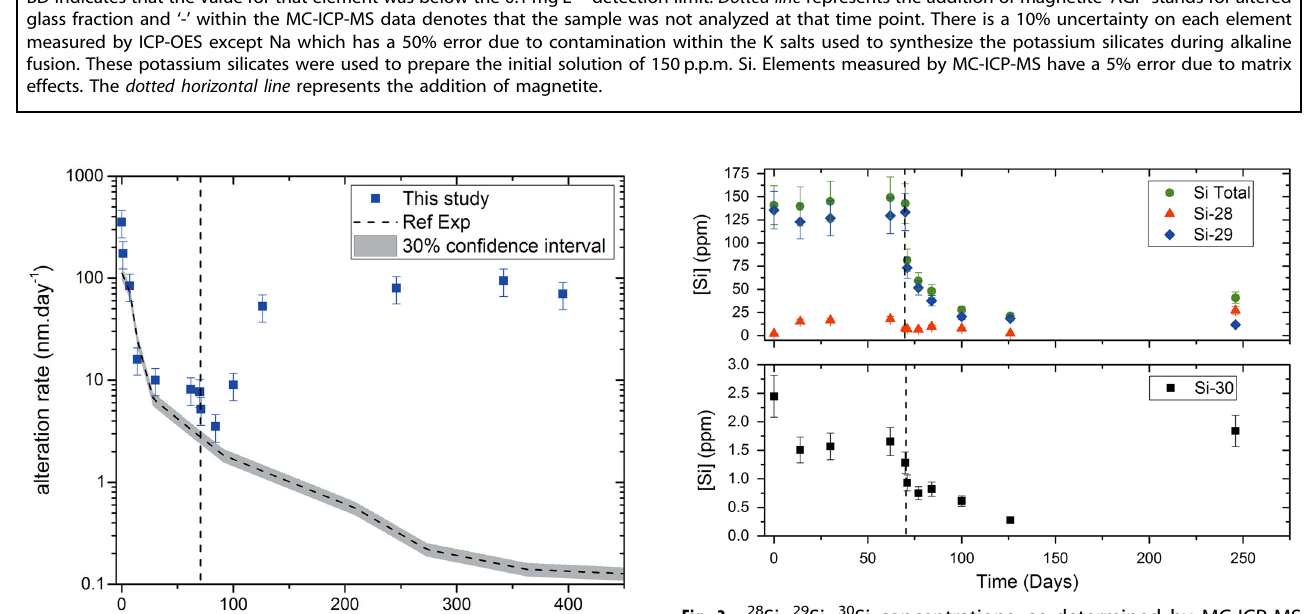
Fig. 3 28 Si, 29 Si, 30 Si concentrations, as determined by MC-ICP-MS solution analyses. The lower graph shows only 30 Si as it makes up less than 1% of the total Si concentration. The dotted black line represents the addition of magnetite at day